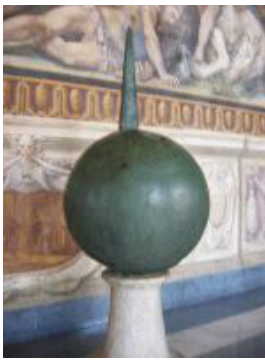
Figure 2.: Model of the antique setting